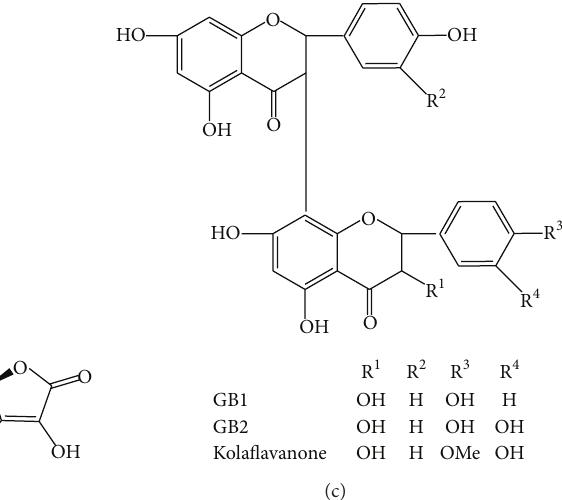
Figure 1: Chemical structure of (a) chlorambucil (4-[4-[bis(2-chloroethyl) amino] phenyl] butanoic acid), (b) L-ascorbic acid, and (c)